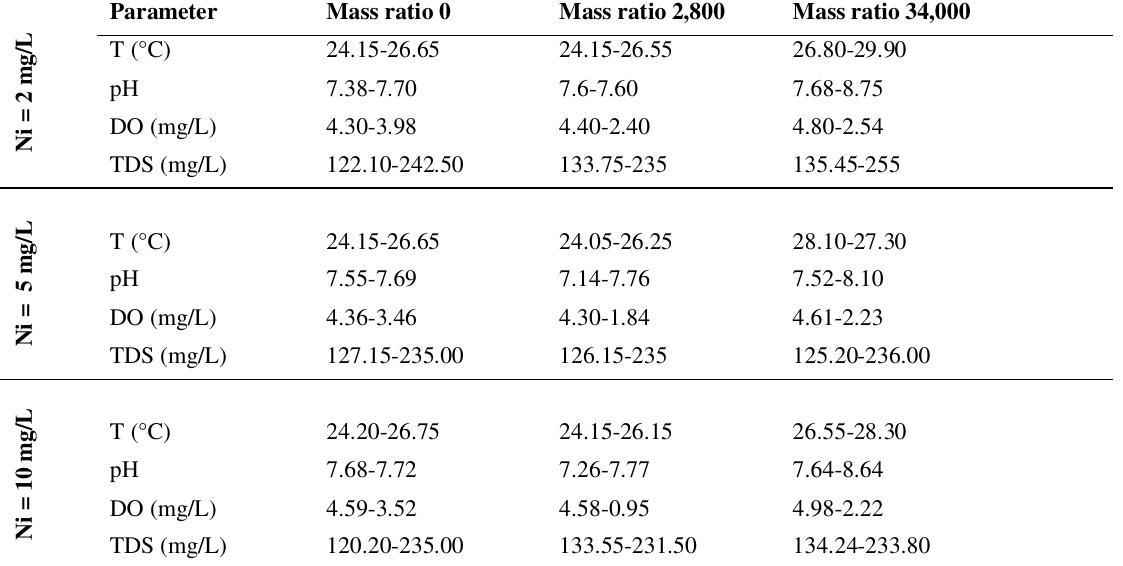
Table 2, Variation of physical parameters in Phytotoxicity test in SSB system Parameter Mass ratio 0 Mass ratio 2,800 Mass ratio